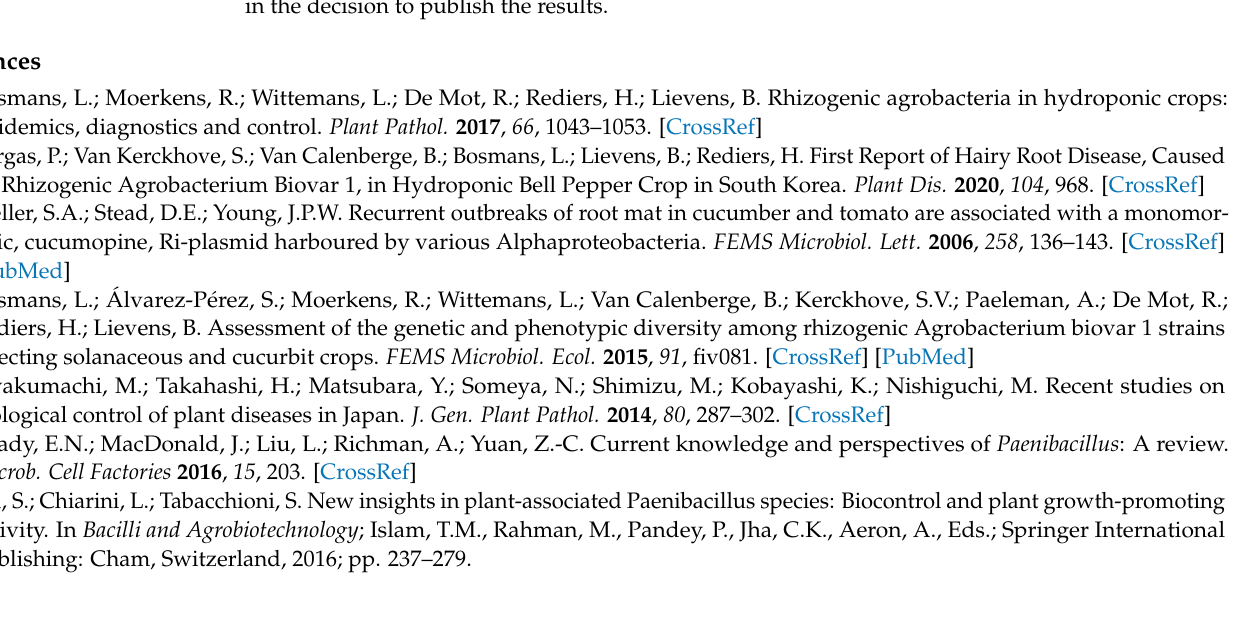
Table S3: Statistical analysis of stem thickness for healthy and HRD-infected plants for 2019 and 2020